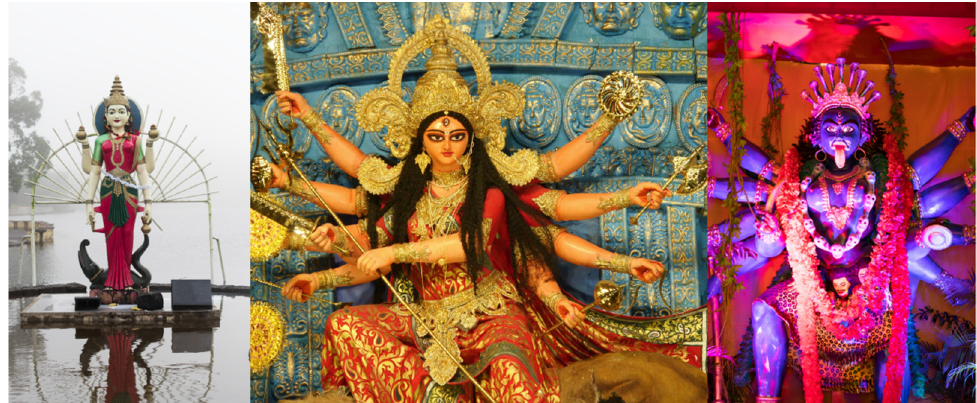
Figure 7. Here we see three expressions of Ś akti, Ś iva’s consort. On the left we have P ā rvat ī (picture by Robertobinetti70, Canva ), who looks very much like Lak ṣ m ī : attractive. Then in the middle we have Durg ā (picture by Pabitra Chakraborty, Canva ), who is attractive but also fierce, displaying various weapons. On the right we have K ā l ī (picture by anonymous, Canva ), who is outraged over the evil she destroys.